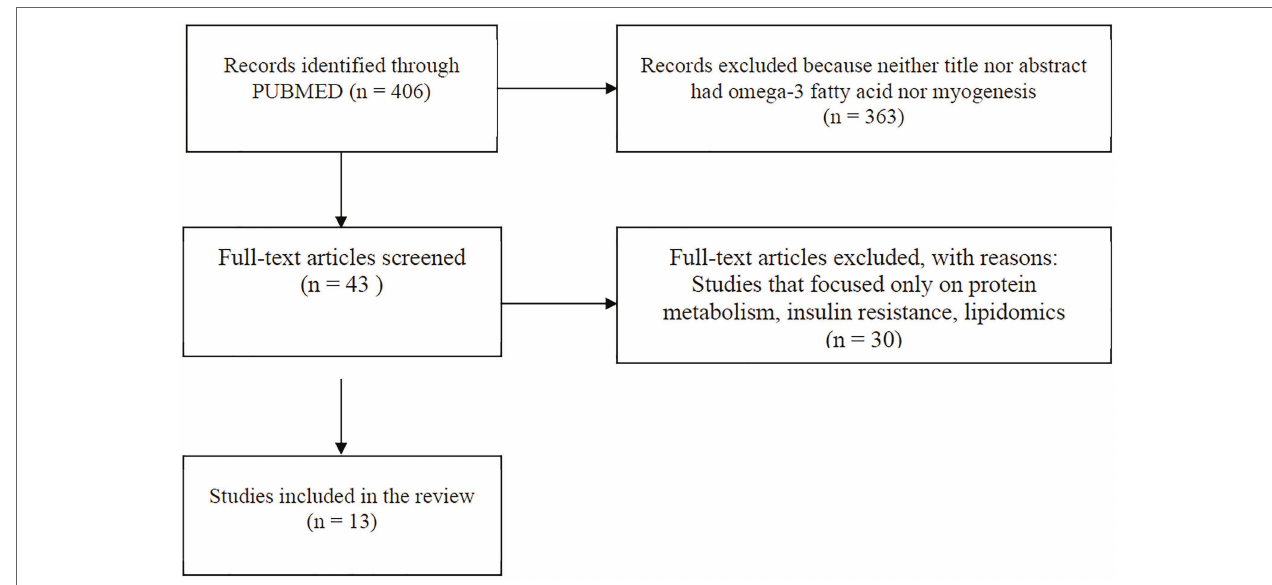
FIGURE 2 | Flowchart showing search method. Papers included were those published between January 2015 and January